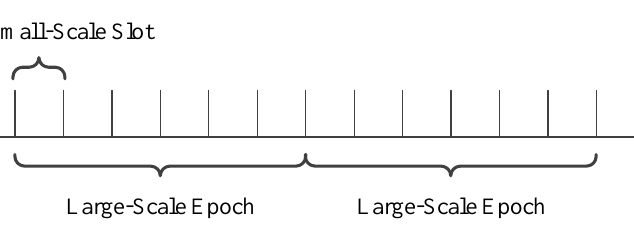
Figure 4. Large-scale epoch and small-scale